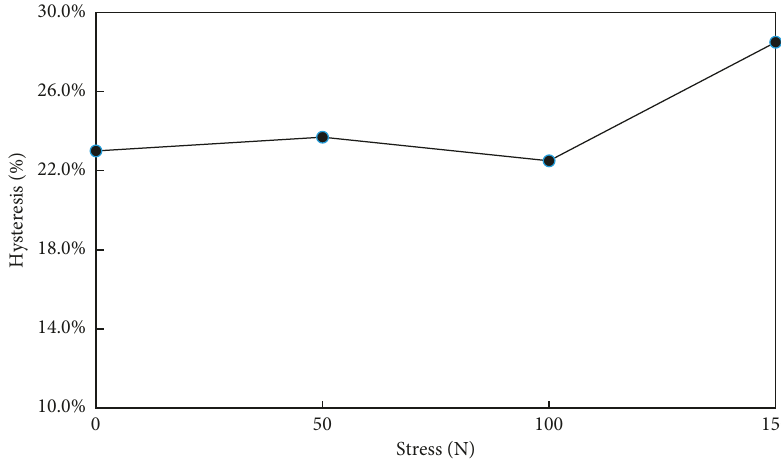
Figure 4: Hysteresis of KNN element in the asphalt concrete under different